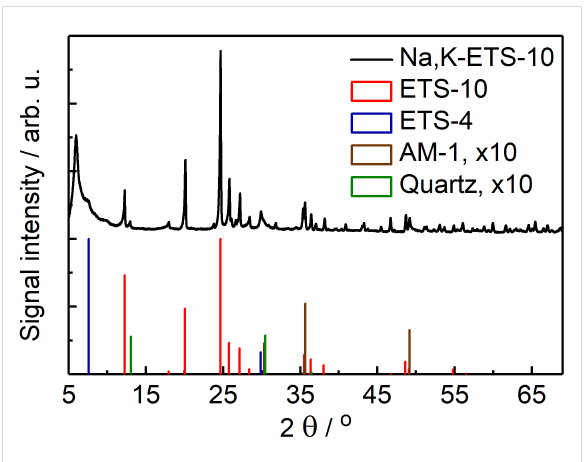
Figure 2: X-ray diffractograms of the as-synthesized ETS-10 material (Na,K-ETS-10, top) and of the reference reflections of ETS-10, ETS-4, AM-1 and quartz according to [33-36]. Signals of AM-1 and quartz are 10-fold amplified for visibility.